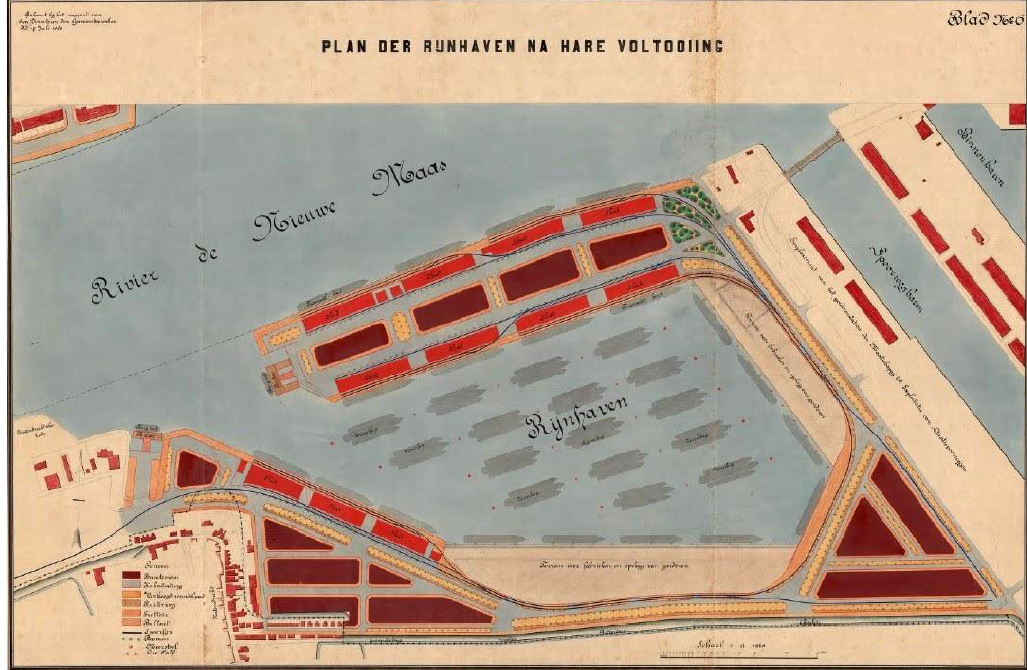
Figure 5. Expansion and zoning plan of the Rijnhaven by Gerrit de Jongh, director of the Rotterdam Municipal Works, 1888. This is one of the first plans for the south bank of Rotterdam, with land use exclusively for port activities. Source: de Jongh (1888).